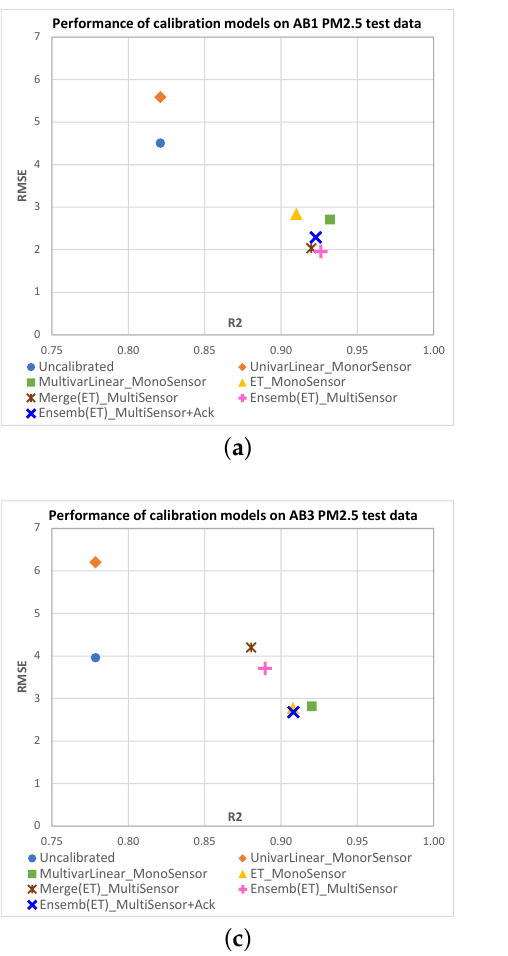
Figure 9. Scatterplots of R 2 vs. RMSE mean values obtained on test data for each AIRBEAM PM 2.5 sensor as candidate sensor with the different calibration models. The ideal performance is the point with RMSE = 0 and R 2 = 1, which is the lower right corner of the plots. Points closest to that corner represent models with better performance. Subfigures correspond to the following PM 2.5 candidate